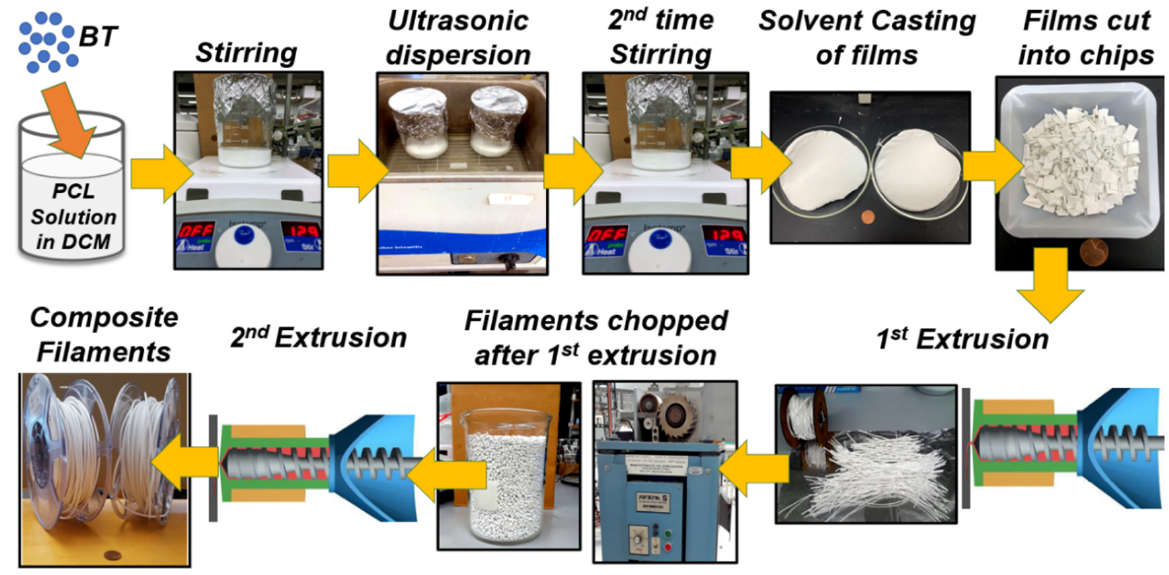
Figure 1. Composite filament development. Schematics show the entire workflow of developing the polycaprolactone–barium titanate (PCL-BT) composites and the 3D-printable PCL-BT filaments.